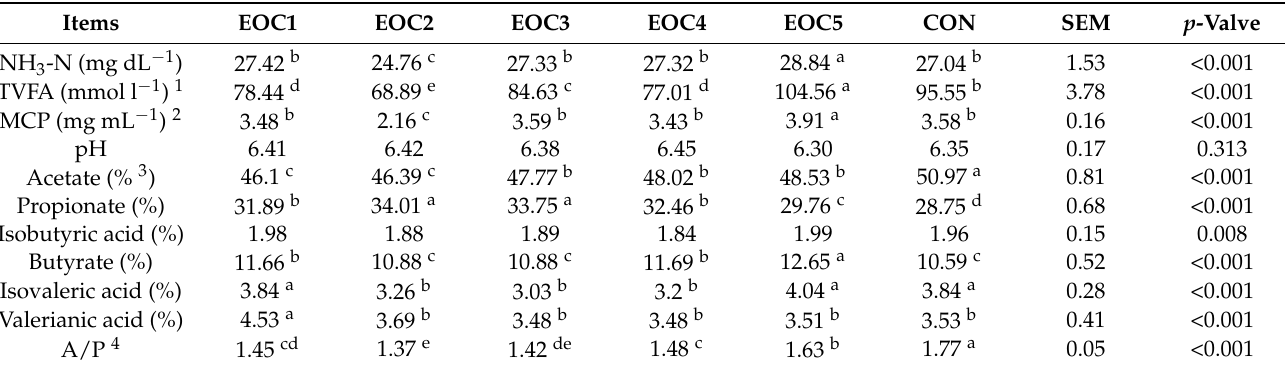
Table 3. Effects of EOC on rumen fermentation